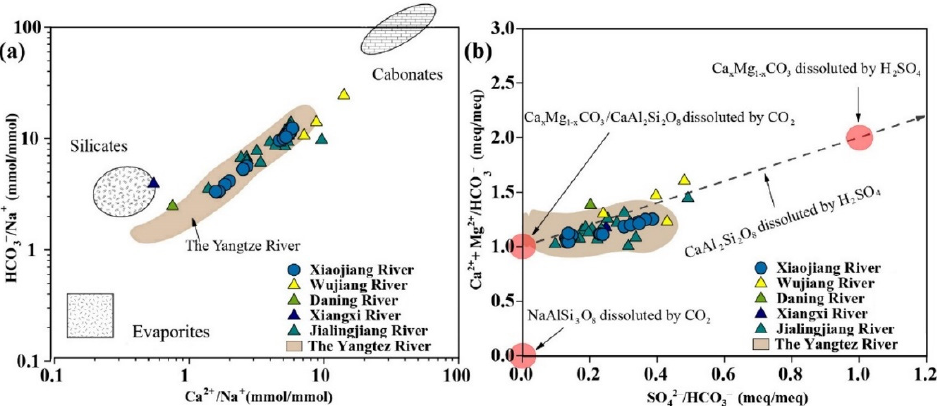
Figure 5. Mixing graph of ( a ) [Ca 2+ ]/[Na + ] and [HCO 3 − ]/[Na + ] mole ratio and ( b ) mole ratios of [SO 42 − ]/[HCO 3 − ] and [Ca 2+ + Mg 2+ ]/[HCO 3 − ]. The closer the samples were to an end-member, the greater the ionic ratios were affected by that end-member. The data of Wujiang River [53], Daning River [27], Xiangxi River [27], Jialingjiang River [32], and Yangtze River [33] in the figure are reported by previous studies.